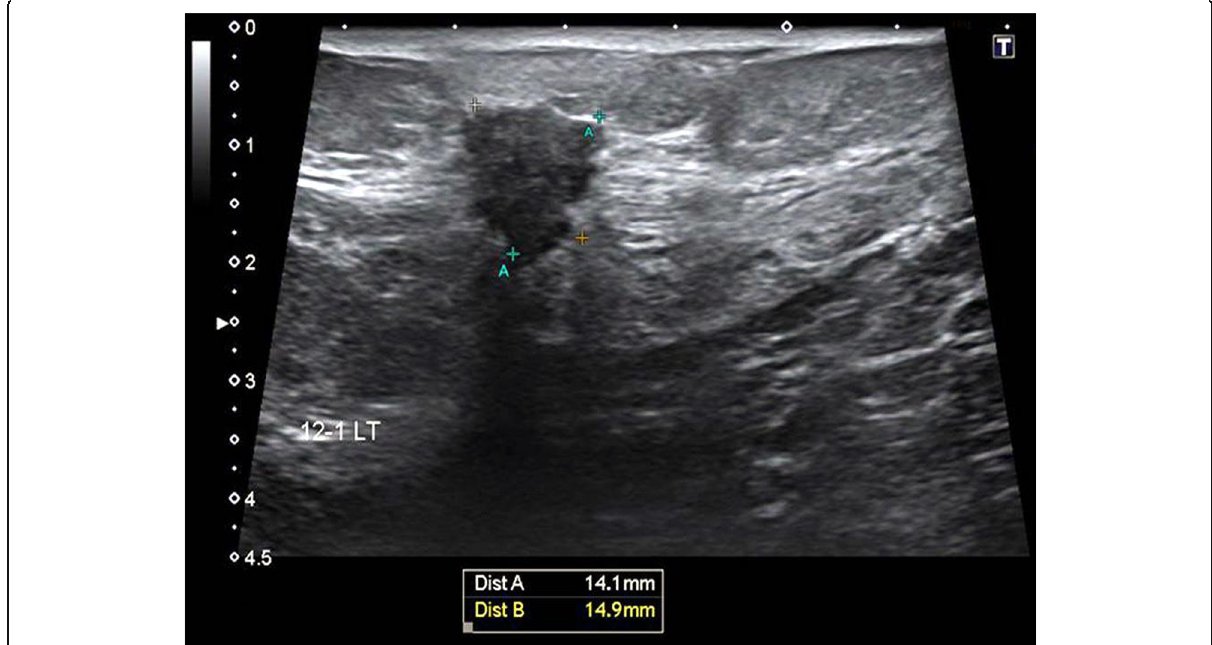
Fig. 2 B-mode ultrasound showed irregular hypoechoic speculated mass with antiparallel orientation and posterior shadowing measuring about (14.1 × 14.9 mm), assessed as BIRADS 5. Pathology: true cut biopsy revealed infiltrating duct carcinoma grade III. Biological markers: ER positive, PR positive, HER/neu-2 negative, and Ki67 positive